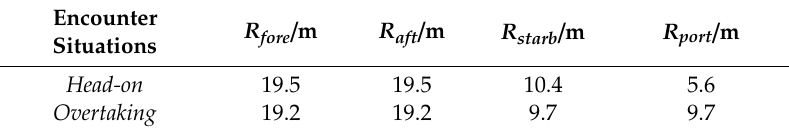
Table 6. Dimensions of the Coldwell model.